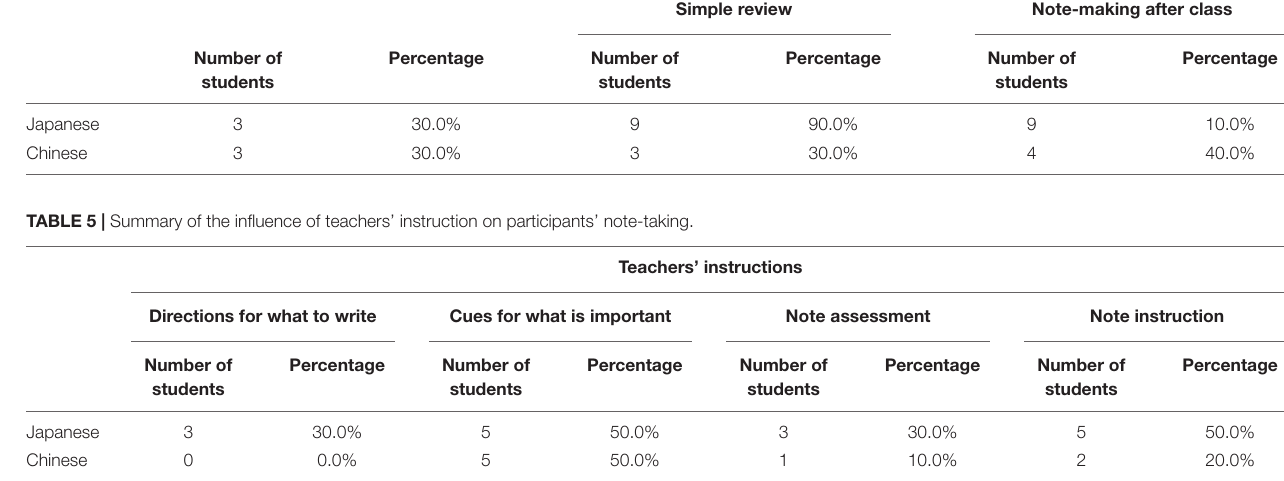
TABLE 4 | Summary of the influence of beliefs on participants’ note-taking.